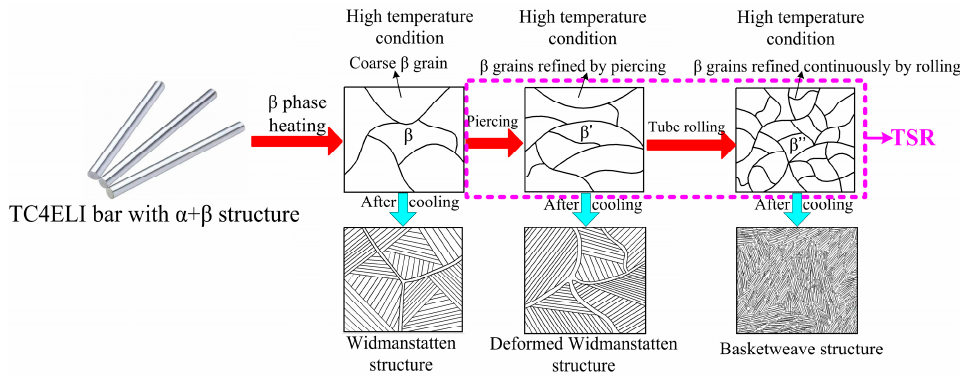
Figure 13. Microstructure evolution in TSR process.